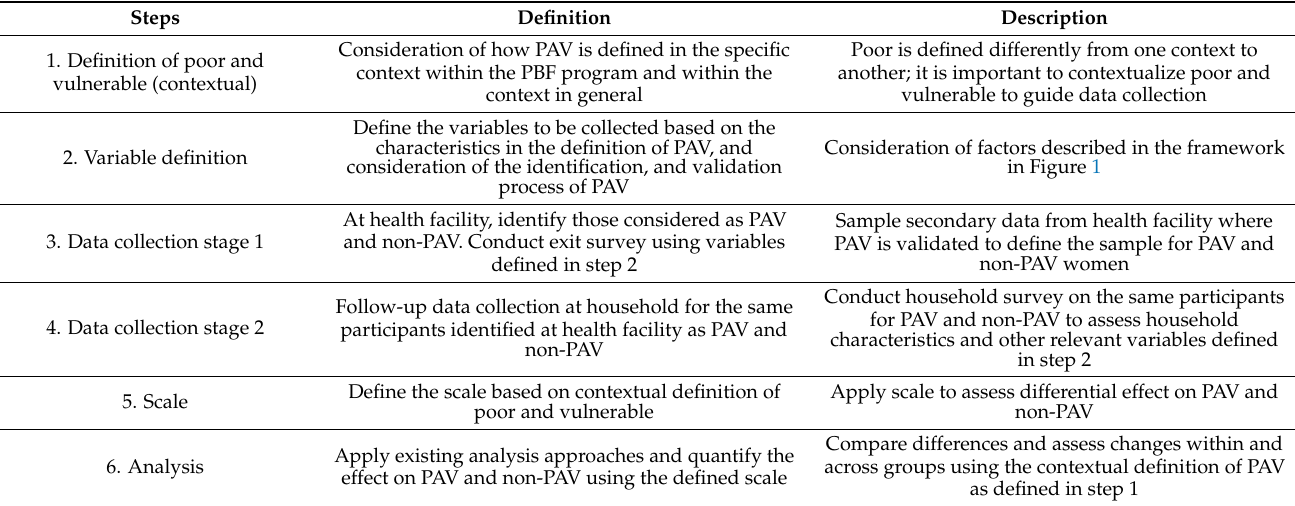
Table 7. Proposed steps for data collection to assess effect of PBF on equity for maternal